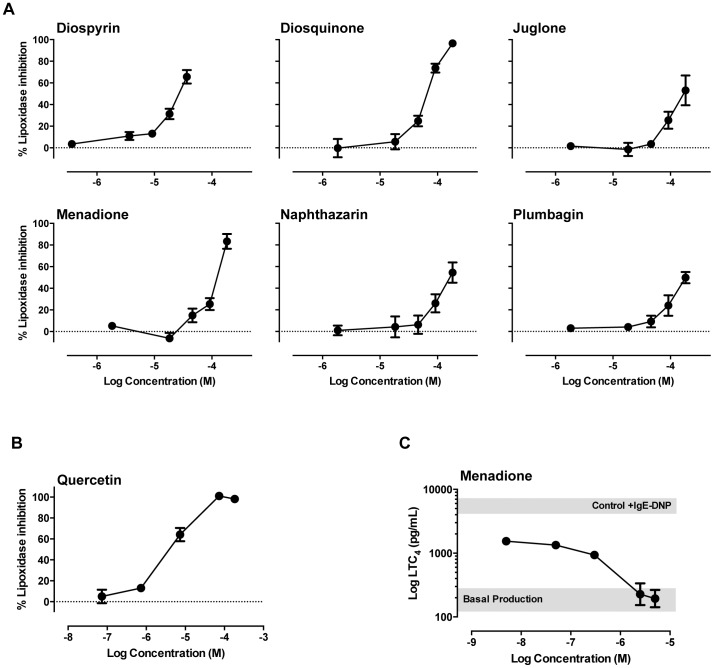
Lipoxidase inhibition and leukotriene C4 production.Soybean lipoxidase inhibition by individual naphthoquinones (A) and by quercetin (B) in a cell-free assay and inhibition of leukotriene C4 production in IgE/antigen-stimulated RBL-2H3 by menadione (C). Grey box represents LTC4 production of stimulated (upper) and non-stimulated (lower) control cells. n = 3–5.